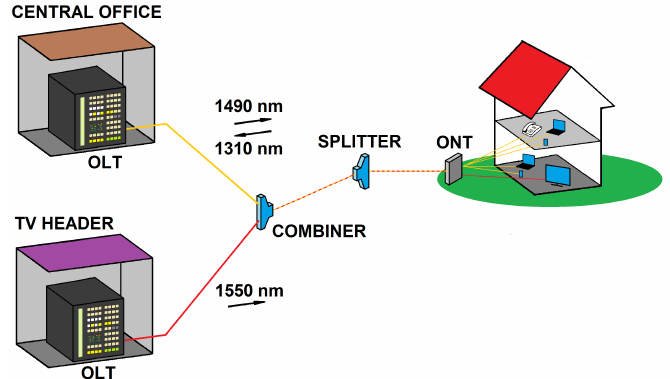
Figure 2. Scheme of the structure of a GPON to implement triple-play services using the third lambda at